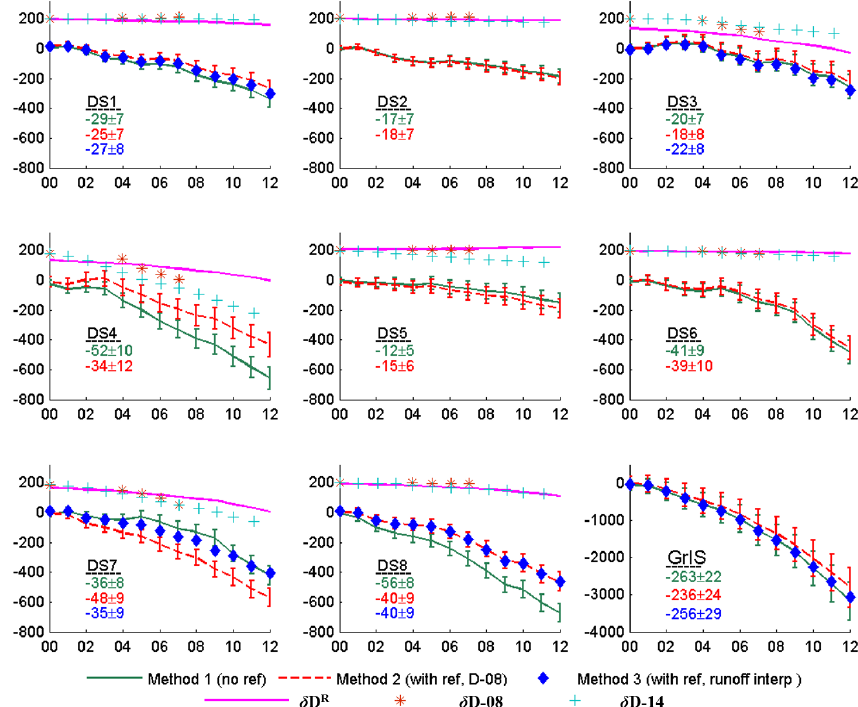
Figure 3. Comparison between cumulative TMB (2000–2012) obtained with three different methods. method 1, using no reference TMB, is shown with a green curve. For method 2 (red markers and curve), the reference discharge is based on the estimation from D-08, while the discharge estimation from D-14 is used ( δ D-14) for the years after 2000. Method 3 (blue markers and curve) interpolates the reference discharge using the modeled runoff data (only in DS1, DS3, DS7 and DS8), is dented by δD R . δ D-08 refers to the discharge estimated using D-08. All the discharges are shifted upward by 200Gt for visualization purposes. The numbers in each plot indicate the annual TMB change rates in Gtyr − 1 . The x axis shows the last two digits of the years from 2000 to